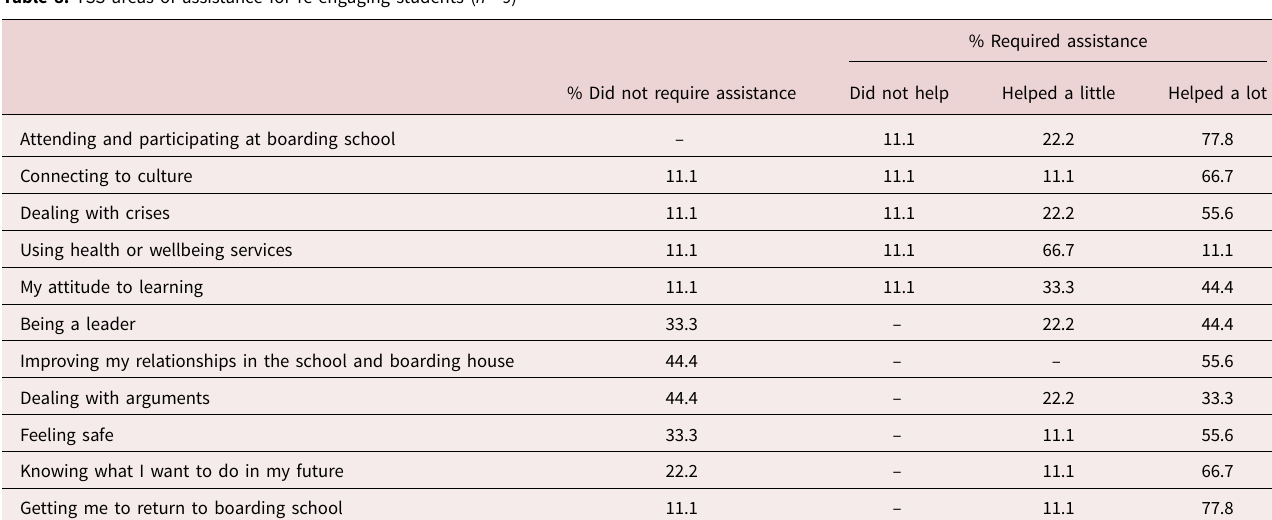
Table 8. TSS areas of assistance for re-engaging students ( n =9)